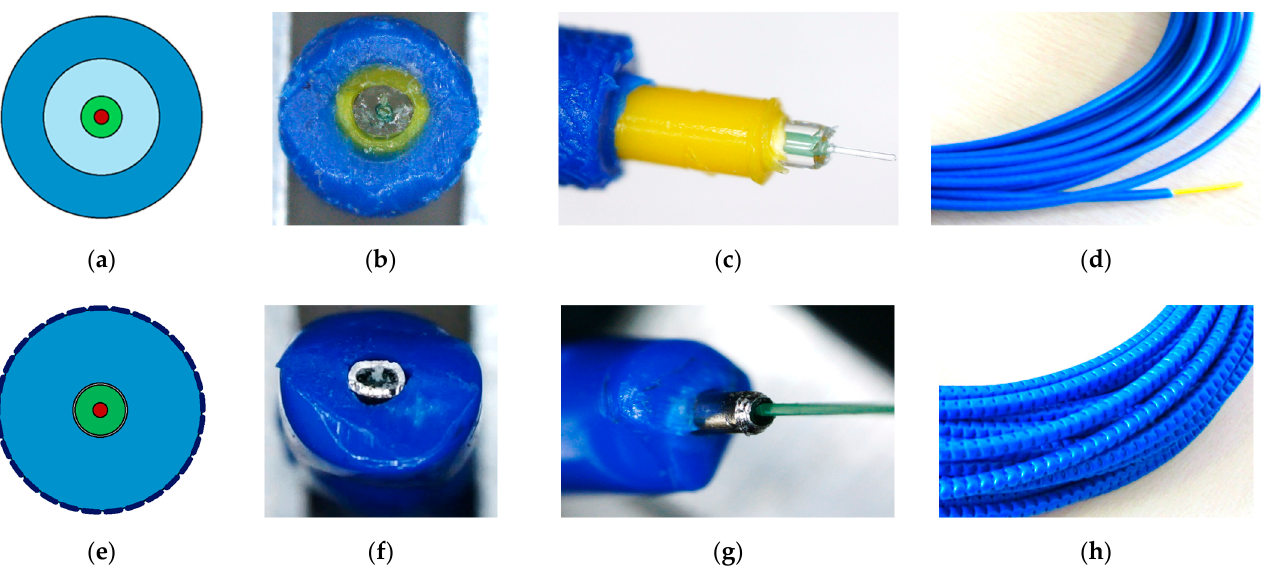
Figure 9. Example layered cables C1 and C2, respectively : ( a , e ) design; ( b , f ) cross-section; ( c , g ) side view with particular layers; ( d , h ) the view of outer surface.